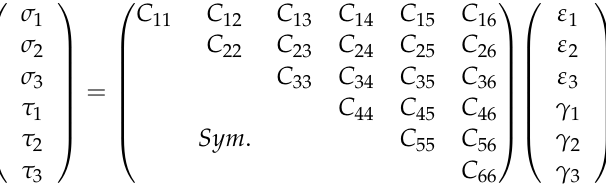
where σ i , τ i , ε i , and γ i are the normal stress, shear stress, normal strain, and shear strain, respectively. The elastic constants of AuCu 3 , AuCu, and Au 3 Cu calculated herein and the reported values are listed in Table 2. The two sets of data are in good agreement. The elastic flexibility matrix was obtained by inverting the elastic stiffness matrix (i.e., S ij = [ C ij ] − 1 ). According to the symmetry of Au–Cu IMCs, to express the elastic flexibility matrix, there